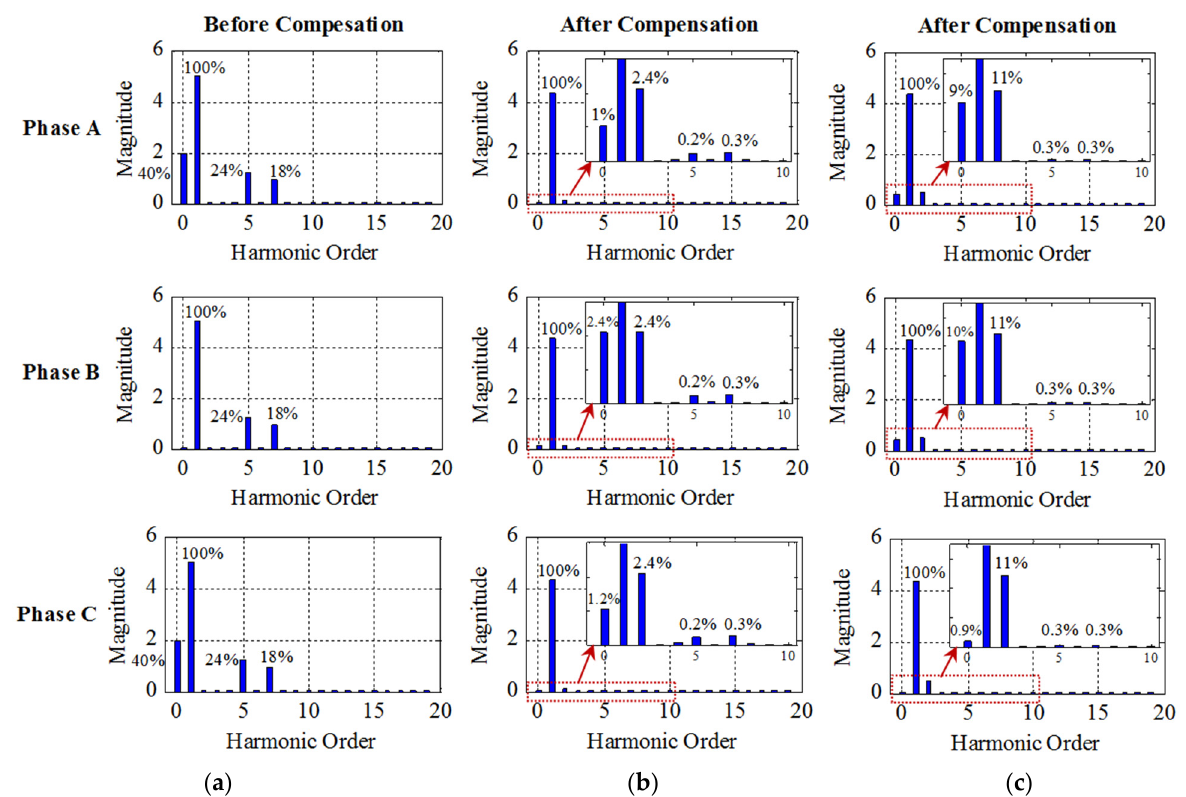
Figure 12. Spectrums of the source current at intervals 0.5 ≤ Time < 1 s for Case 2.; ( a ) Before compensation; ( b ) After compensation with ADALINE method; ( c ) After compensation with PQ method. Table 3. The average performance value for Case 2.